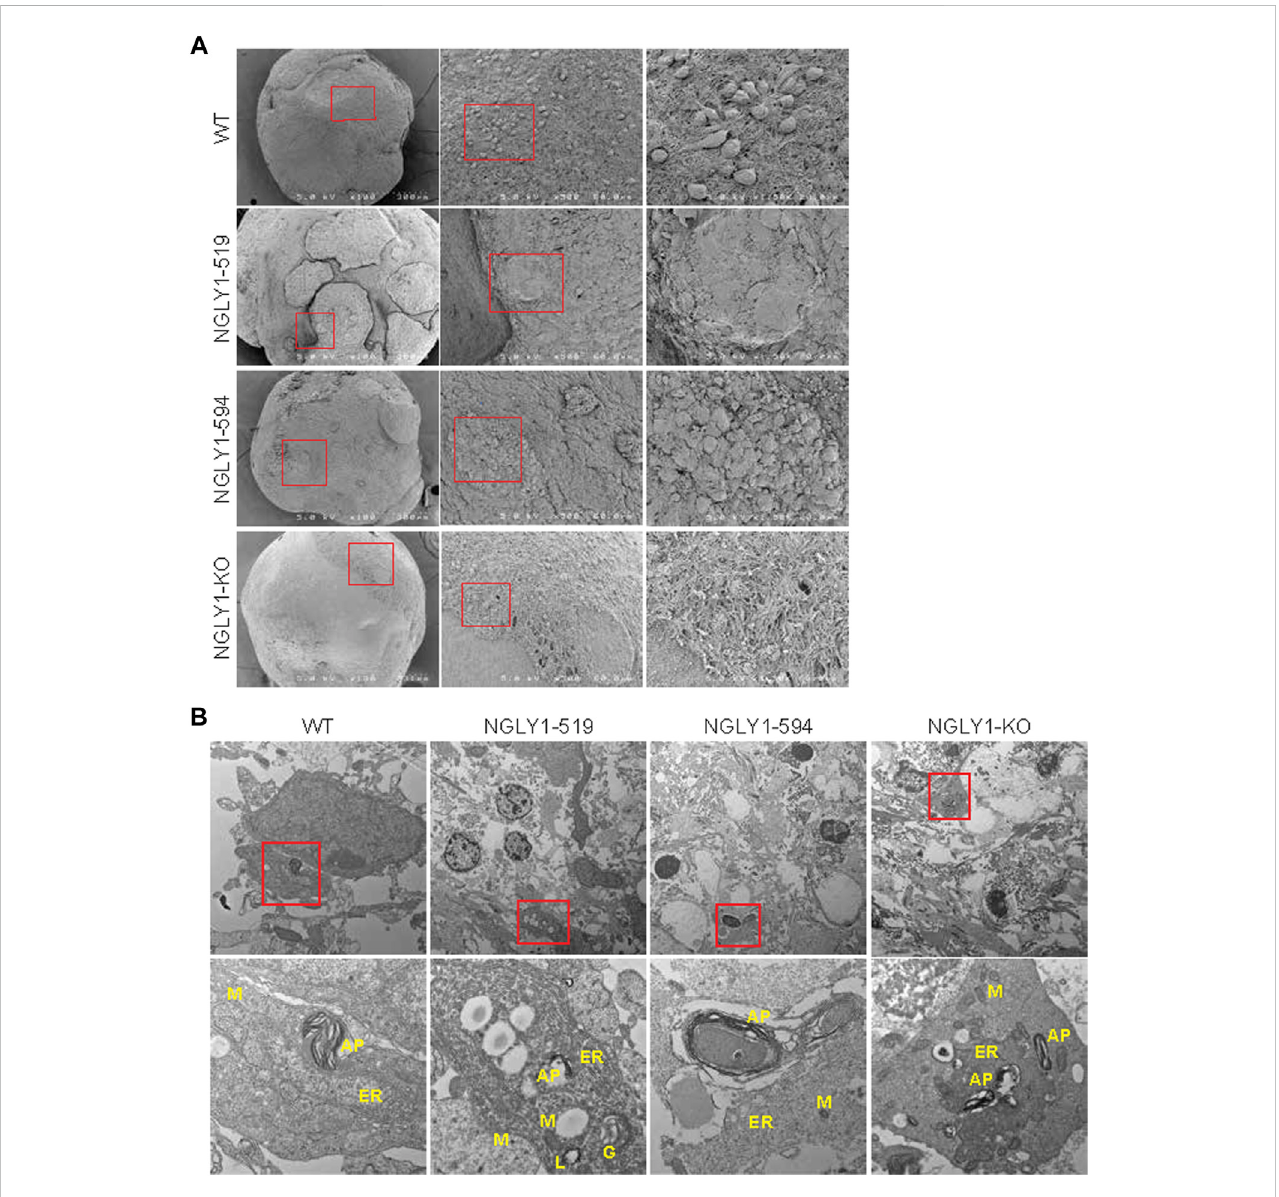
FIGURE 6 Electron microscopy characterization of midbrain organoids. (A) SEM images at 100x, ×500 and ×1500 magni fi cation. (B) TEM images at 1000x and 6000x magni fi cation showing cellular organelles (ER-endoplasmic reticulum, M-mitochondria, L-lysosome, G-golgi, AP-autophagosome).